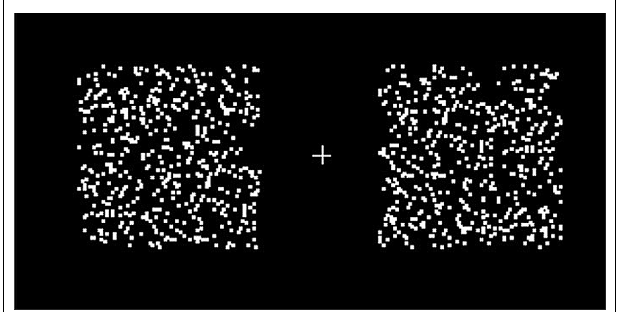
FIGURE 1 |Two moving random dot patterns were presented, one to each hemifield. Subjects were asked to fixate the cross throughout the experiment.The random dot patterns consisted of 500 randomly scattered 0.05 ◦ squares in a 5 ◦ square region.When set in motion, the dots oscillated with 100% coherence, at a period of 833 ms. Motion directions were different for different conditions (see main